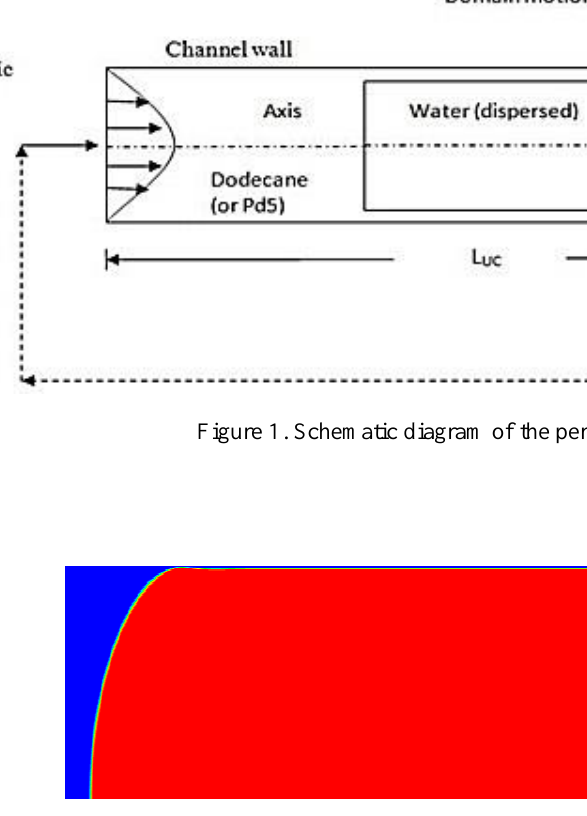
Figure 2. Cut-plot of CFD model. The red-coloured region shows the dispersed phase droplet, and the blue- coloured region shows primary phase